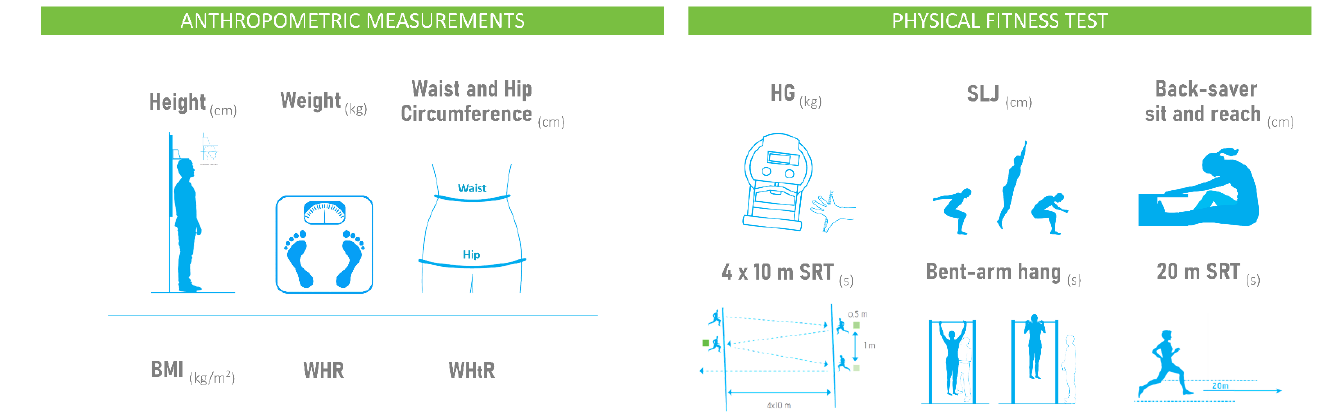
Figure 2. Anthropometric and physical fitness evaluation: DAFIS battery. BMI: body mass index; WHR: waist to hip ratio; WHtR: waist to height ratio; HG: handgrip; SLJ: standing long jump; 4 × 10 m SRT: 4 × 10 m shuttle run test; 20 m SRT: 20 m shuttle run test.